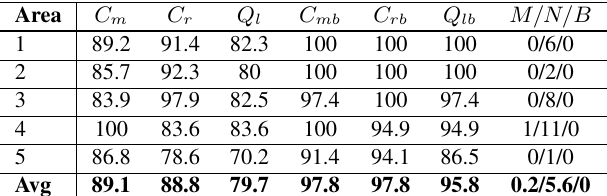
Table 1: Object-based evaluation of building detection results. Object-based: C m = completeness, C r = correctness and Q = quality ( C , C and Q are for buildings over 50 m 2 ) in mb rb lb percentage. Segmentation errors: M = over-segmentation, N = under-segmentation and B = both over- and under-segmentation.